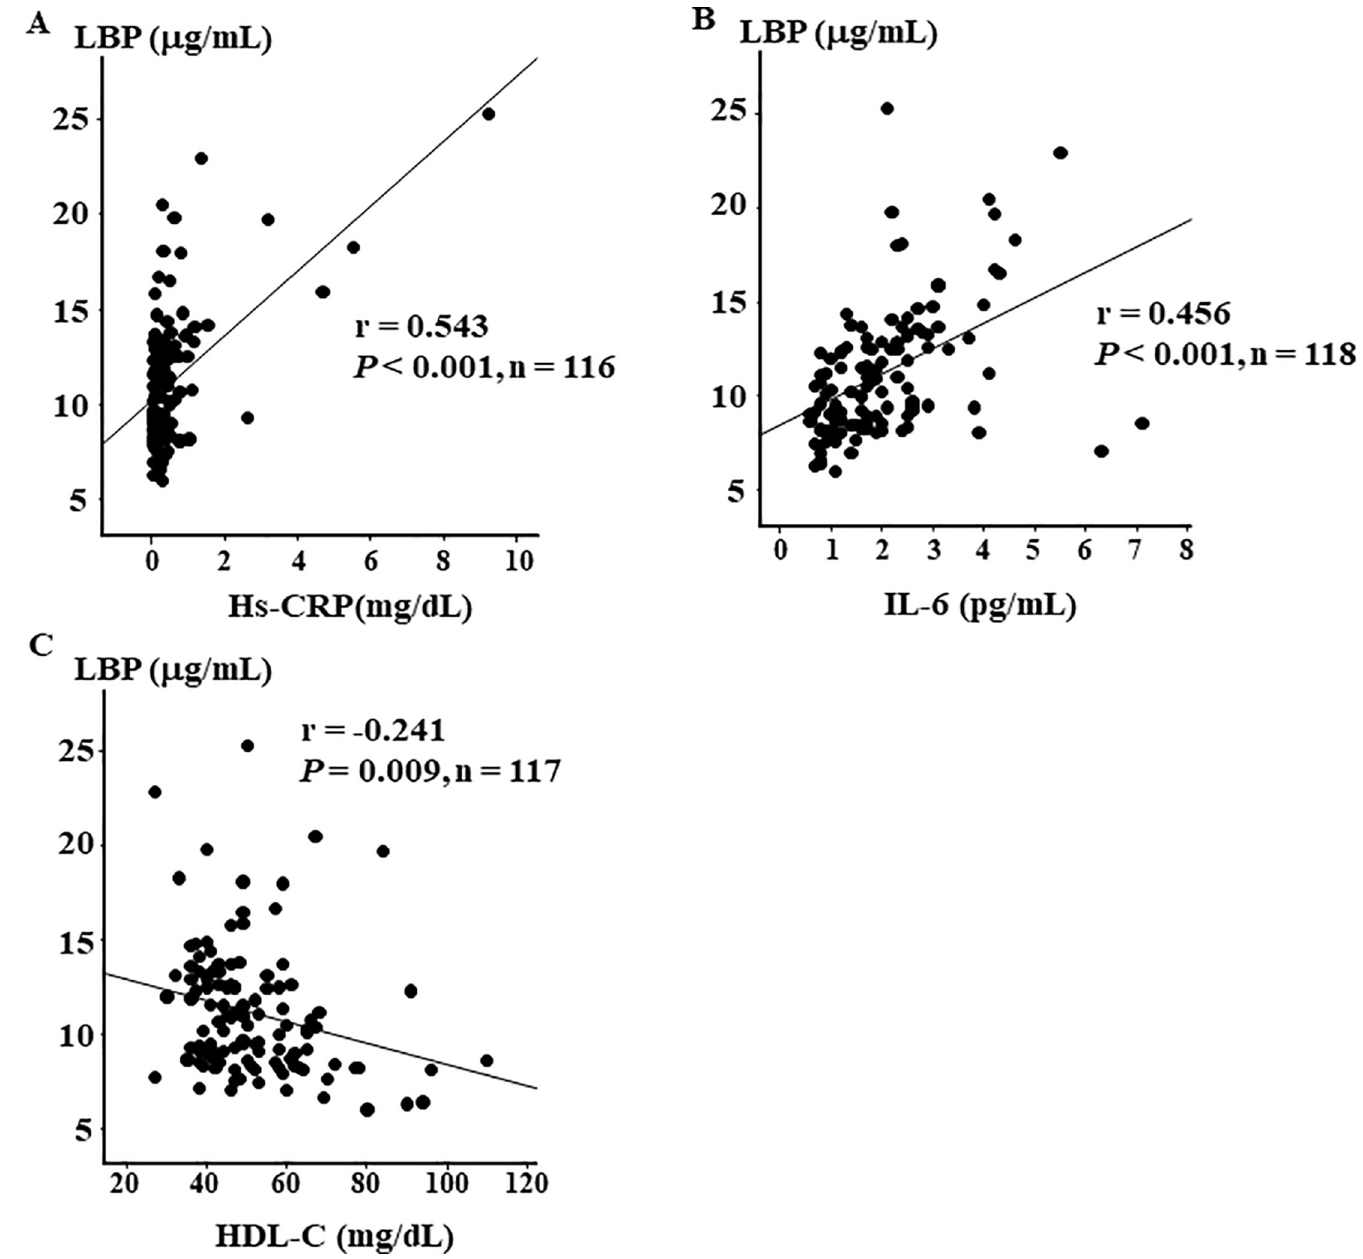
Fig 2. Correlations between LBP, inflammatory markers, and HDL-C. Correlation between (A) LBP and Hs-CRP (r = 0.543, P < 0.001, n = 116), (B) LBP and IL-6 (r = 0.456, P < 0.001, n = 118), and (C) LBP and HDL-C (r = - 0.241, P = 0.009, n = 117).